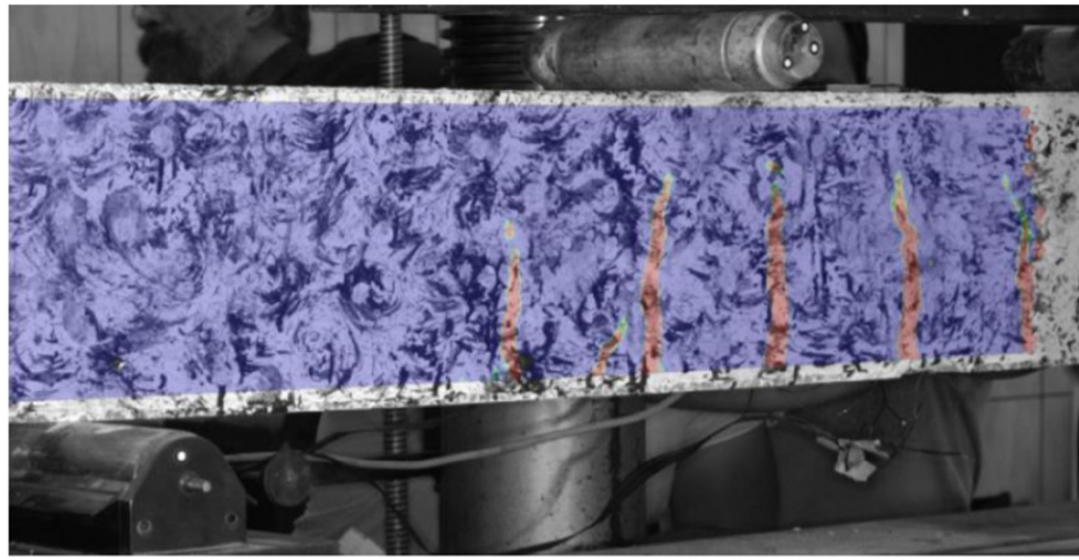
Figure 6. Perpendicular cracks in the element reinforced with composite bars (K2).